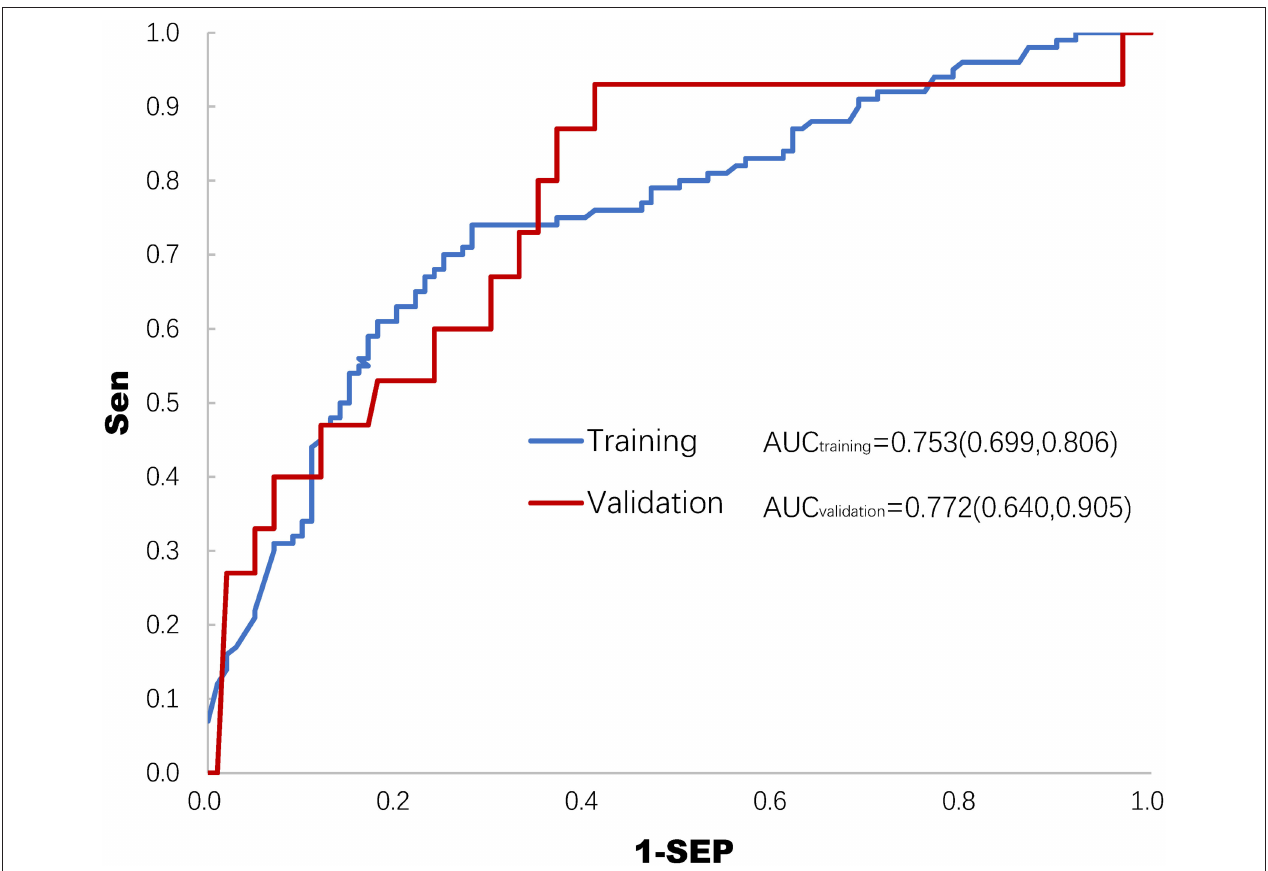
FIGURE 2 | Receiver operating characteristics (ROC) curve of the training set and the validation set for predicting deep sedation practice. AUC, area under the curve of ROC.